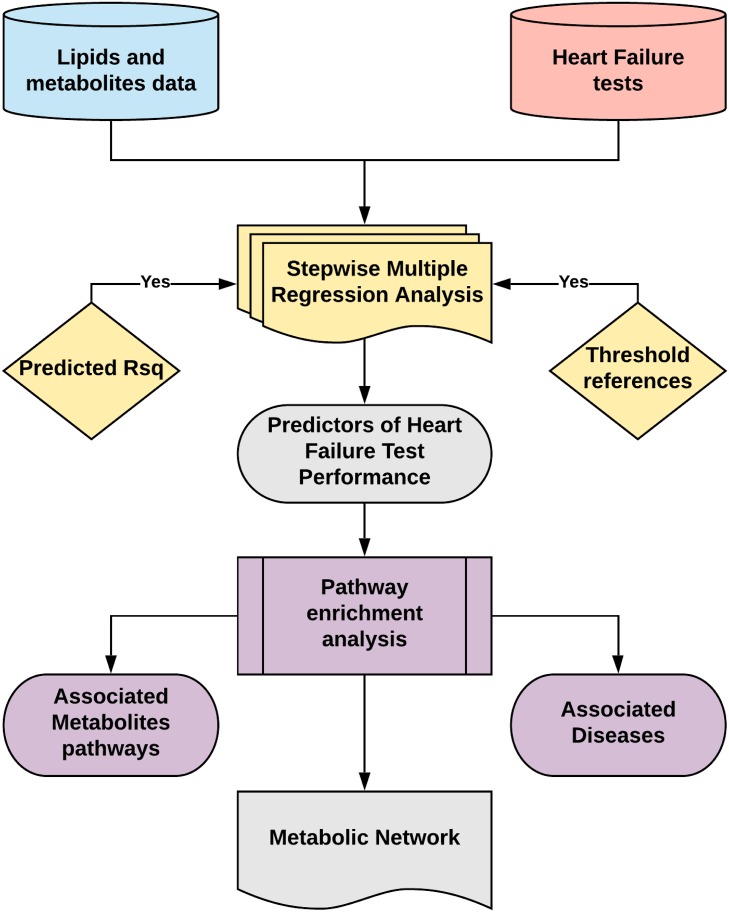
Statistical analysis workflow outlining the steps taken to find predictors of HF test performance using metabolomic and lipidomic data.Stepwise MRA was validated with bootstrap 95% confidence interval of the main regression estimates. Search of published threshold references confirmed the clinical importance of the models. Pathway enrichment analysis revealed the main metabolic pathways and associated diseases enriched using the set of metabolites predicting HF performance. A metabolic network was derived from the analysis confirming several metabolic dysfunctions related to HF described in the literature.